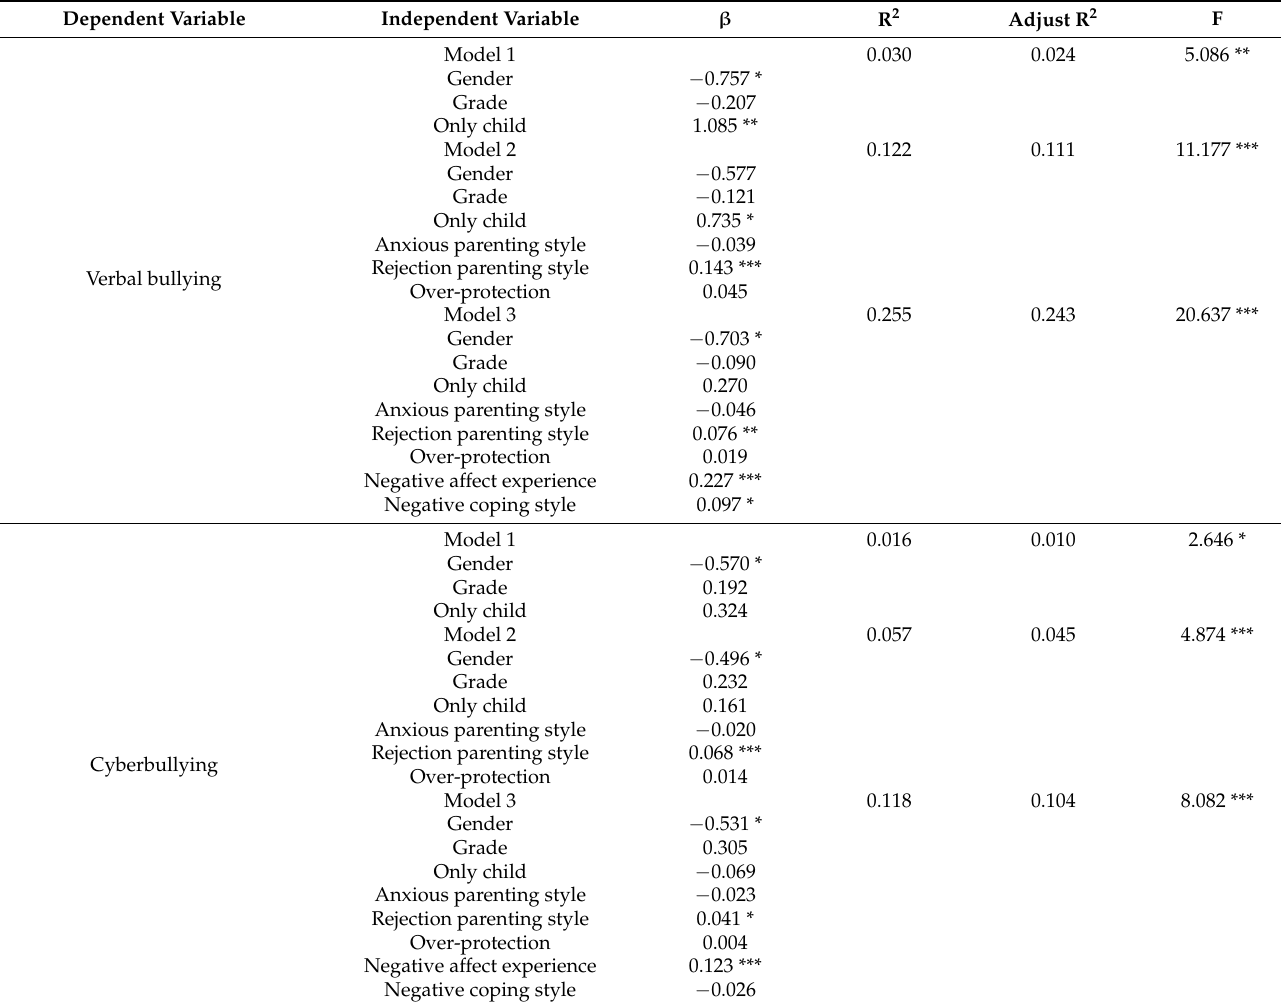
Table 4. Multiple hierarchical regression analysis of the perceived non-physical bullying on negative parenting style, negative affect experience, and negative coping styles (N =